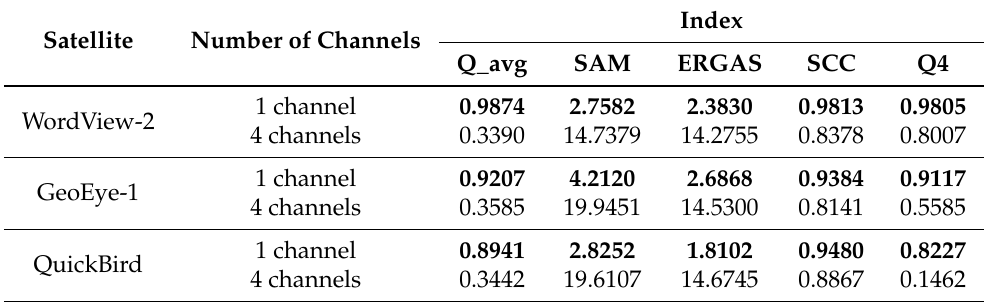
Table 4. Results of the proposed PWNet with one shared weight map channel or four different weight map channels for each CS-based or MRA-based method. The best results are highlighted in